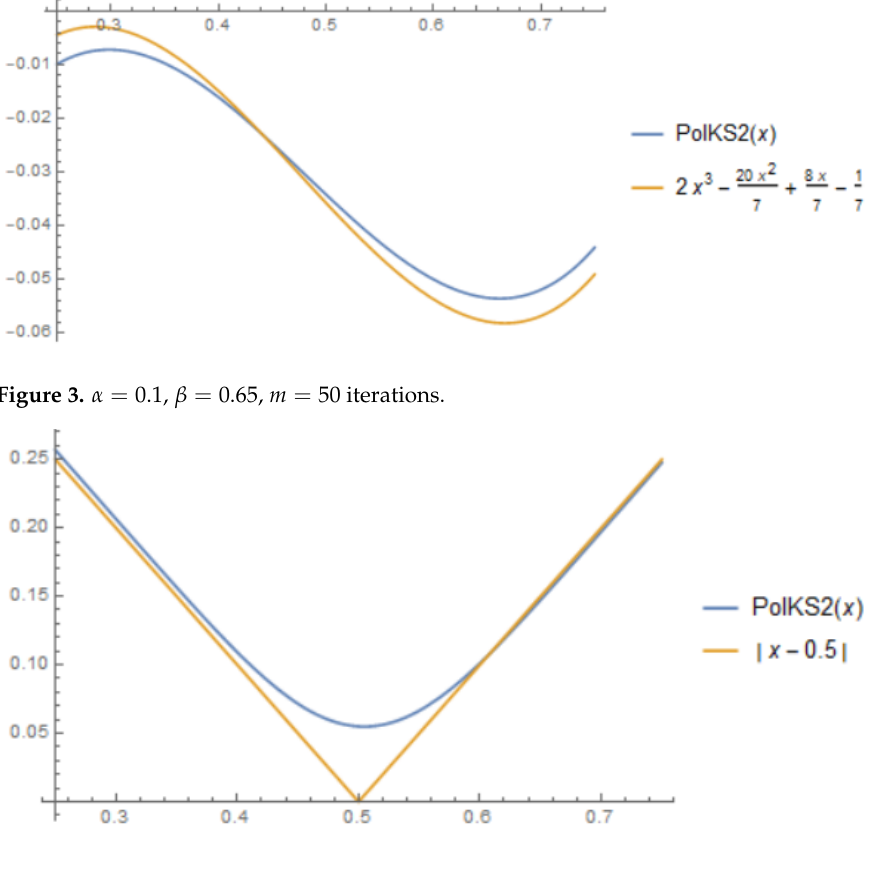
Figure 4. α = 0.1, β = 0.65, m = 50